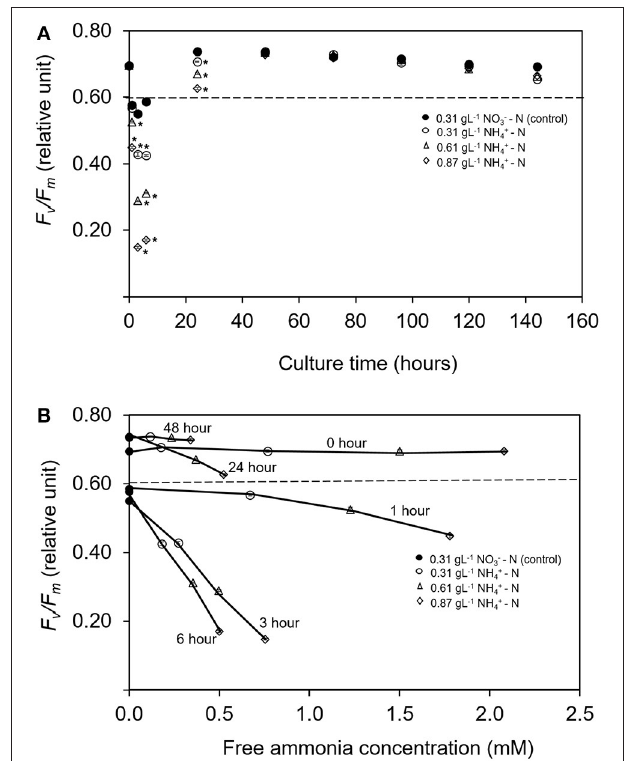
FIGURE 2 | (A) Time course of maximum quantum yield of PS II ( F v /F m ) for Tetraselmis tetrathele during culturing period 144h. (B) Relationship between relative F v /F m with the ratio of free ammonia concentration for T. terathele within 48h. Dotted lines indicate minimum value of healthy cell condition; F v /F m (Geel et al., 1997; Masojídek et al., 2000). Points marked with an asterisk indicate significant differences between treatments on that specific day, p < 0.05. Values are means ± SD ( n =